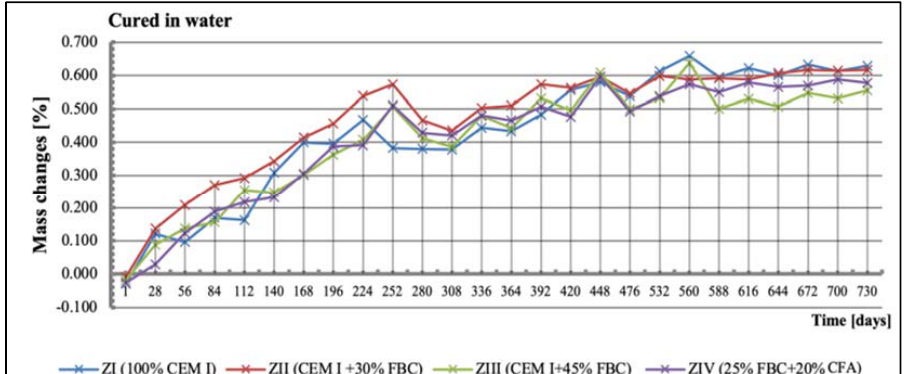
Figure 14. Linear changes of mortars cured in 5% HCl solution for 730 days.